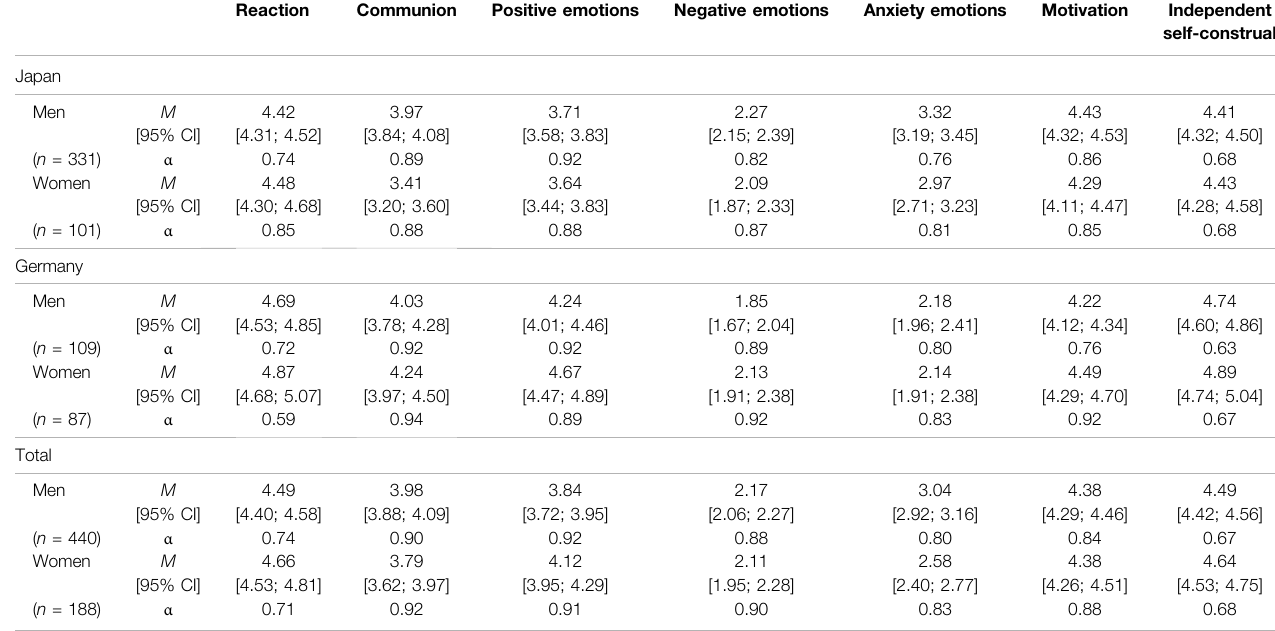
TABLE 1 | Descriptive